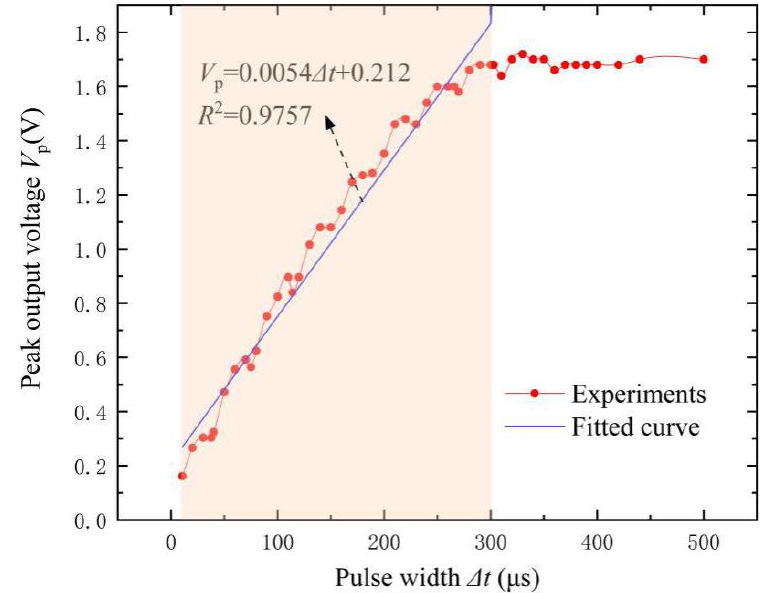
Figure 7. The peak output voltage V p (maximum V o in Figure 3) as a function of the width of the pulsed magnetic field ∆ t for the FeCuNbSiB / piezofiber structure at H bias = 0 Oe. The blue line is the linear approximation. The amplitude of the pulsed magnetic field is 52.3 Oe.